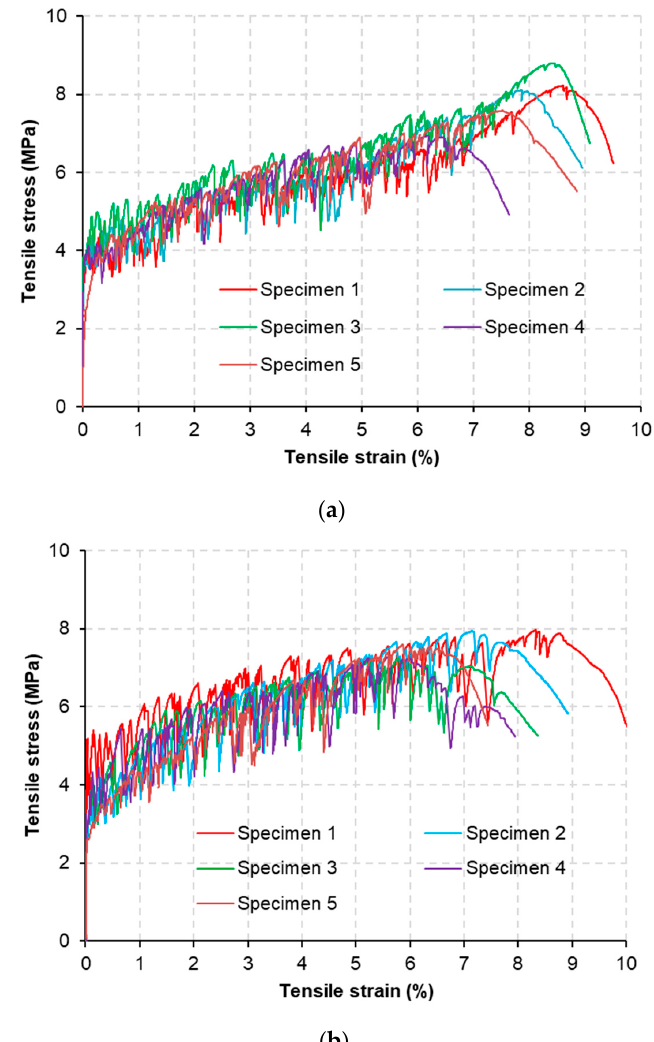
Figure 4. Stress–strain curves of: ( a ) M-W and ( b ) M-O mixtures. Table 5. Tensile properties of SHCC.